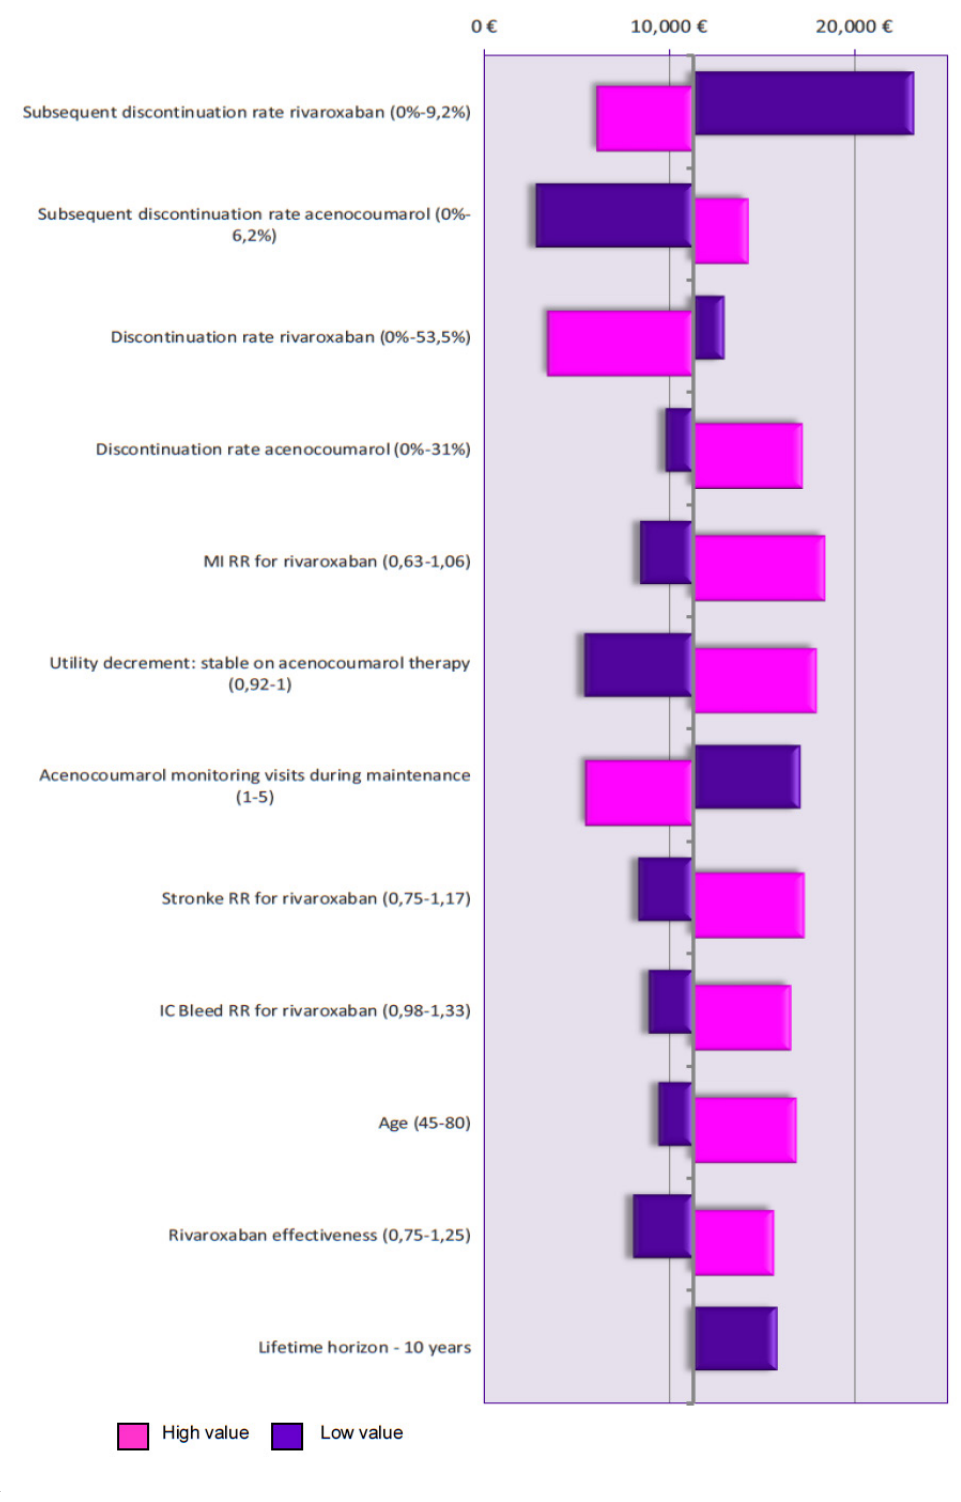
Figure 2. Tornado Diagram showing the Main Drivers (variables and sensitivity ranges) of the Incremental Cost-Effectiveness Ratio